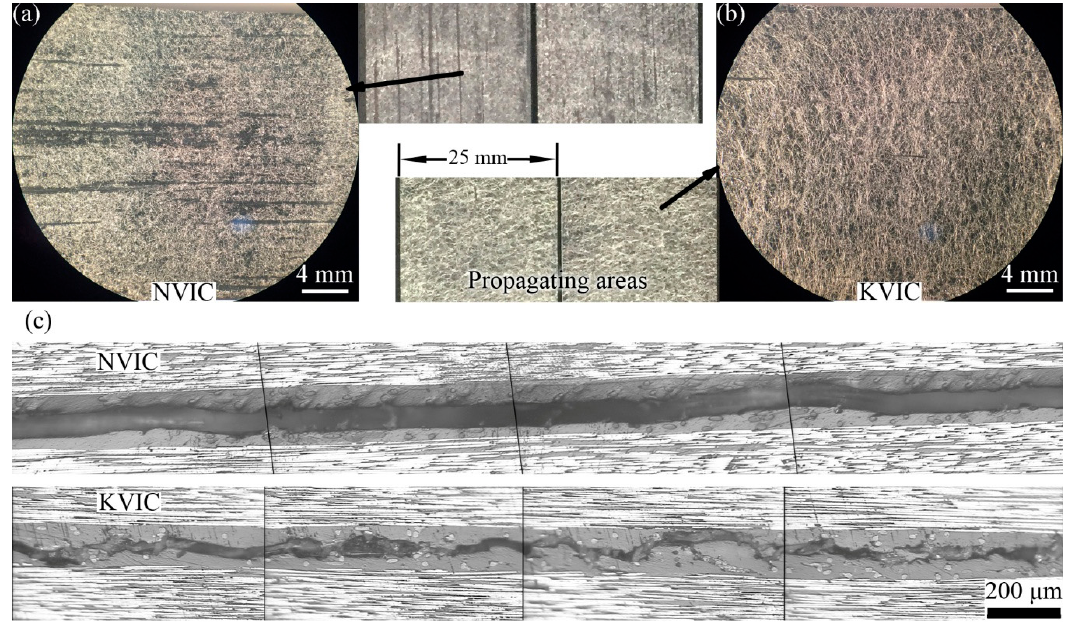
Figure 4. Optical micrographs and images of the Mode I fracture surfaces of the ( a ) NVIC and ( b ) KVIC, and ( c ) cross sectional metallographic micrographs of the Mode I fractured NVIC and KVIC samples.